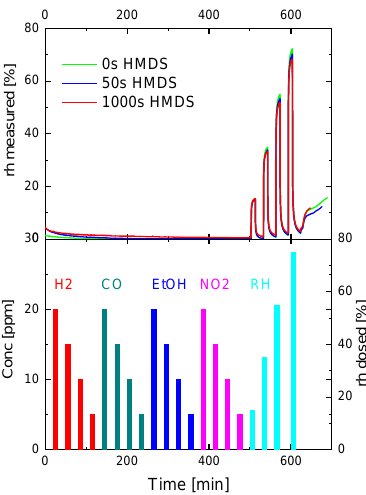
Figure 9. Self-testable EMRS sensor array featuring MOX gas sensor and a capacitive humidity (rh) reference sensor.